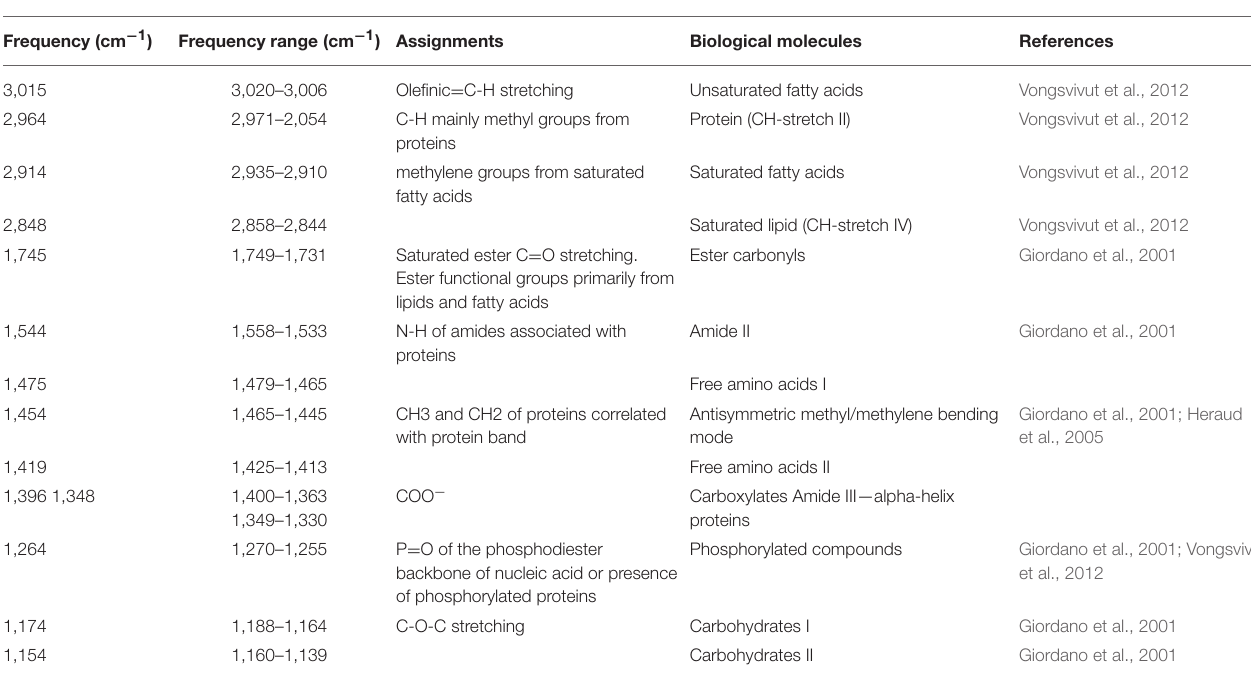
TABLE 1 | Infrared band assignments of Symbiodinium